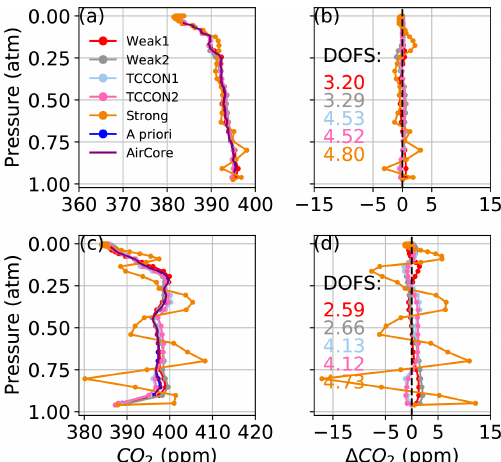
Figure 5. The left-hand panels show CO 2 profiles retrieved using synthetic spectra. 10% is added to the H 2 O profile below 5km for (a) dry conditions on 14 January 2012 and for (c) wet conditions on 23 July 2013. Panels (b) and (d) show the difference between the retrieved profiles and AirCore, corresponding to (a) and (c) respec-